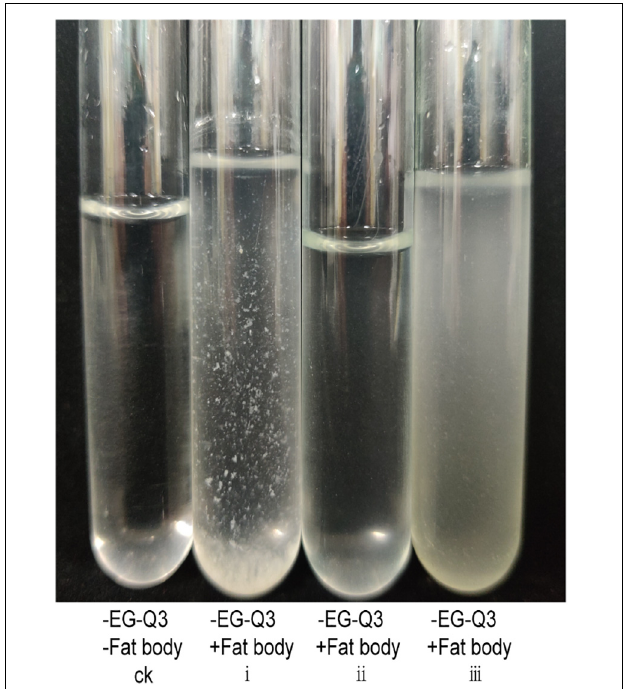
FIGURE 7 | Degradation of fat bodies by EG-Q3 in vitro .